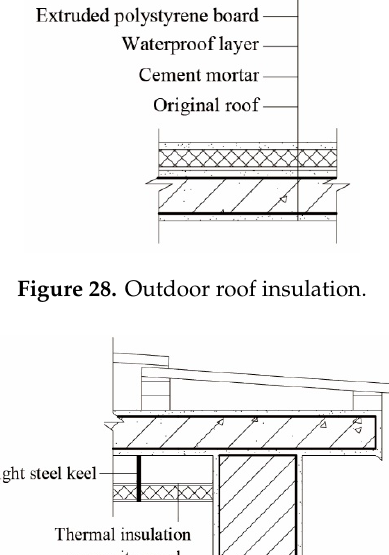
Figure 31. External thermal insulation.